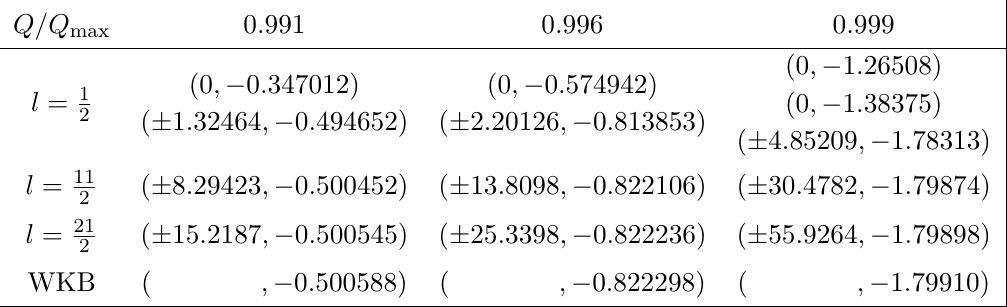
for the case of q = 0 and (cid:3) = 0 : 005. (cid:20) (cid:0)